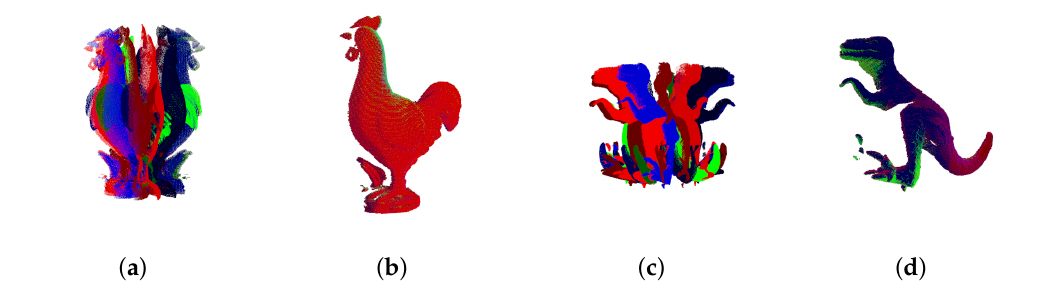
Figure 11. Multi-view registration through our approach on chicken and T-rex model of the UWA dataset. ( a , c ) are input scans from different views and ( b , d ) are the registration results.